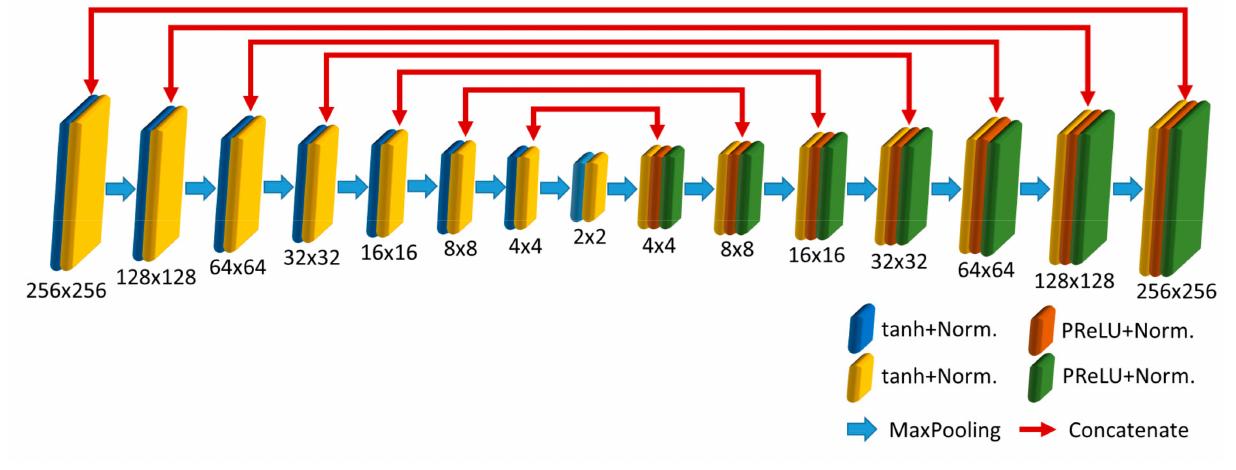
Figure 2. The architecture of the Generator